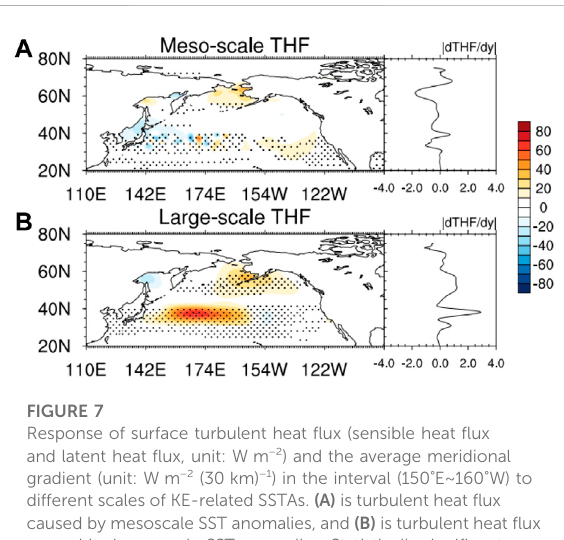
FIGURE 7 Response of surface turbulent heat fl ux (sensible heat fl ux and latent heat fl ux, unit: W m − 2 ) and the average meridional gradient (unit: W m − 2 (30 km) − 1 ) in the interval (150 ° E~160 ° W) to different scales of KE-related SSTAs. (A) is turbulent heat fl ux caused by mesoscale SST anomalies, and (B) is turbulent heat fl ux caused by large-scale SST anomalies. Statistically signi fi cant differences at 90% according to Student ’ s t test are